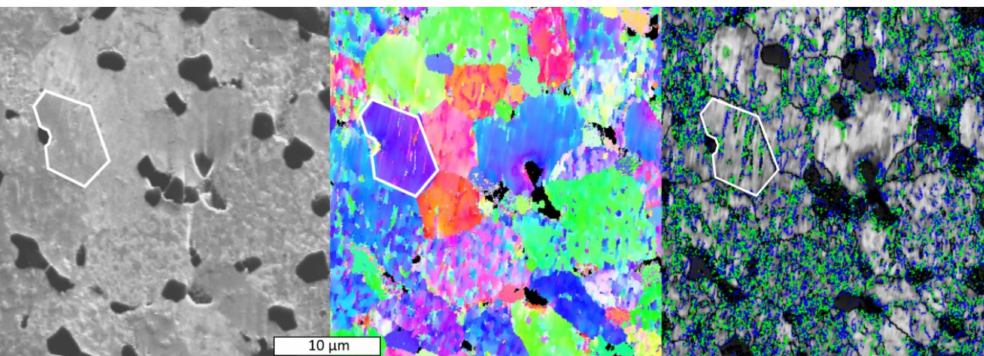
Figure 8. SEM ( left ) and EBSD ( center ) and ( right ) images of the same area, showing the dark SEM areas to be correctly indexed with the BCC structure, and the black EBSD areas to correspond to surface irregularities (marked grain is for the eye’s guidance only); the right image shows the positions of the High-Angle Grain Boundaries (HAGB) (in black) and Low-Angle Grain Boundaries (LAGB) (2–5 ◦ rotation angle in blue, 5–15 ◦ in